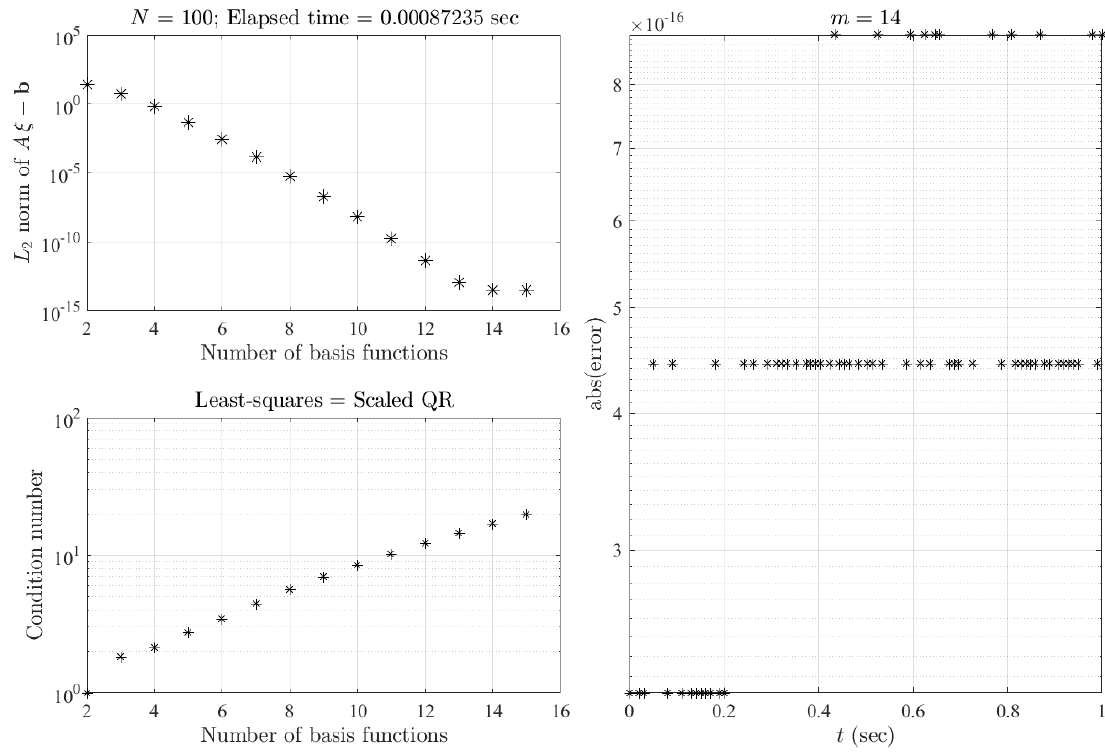
Figure 2. Least-squares-approach results (known analytical